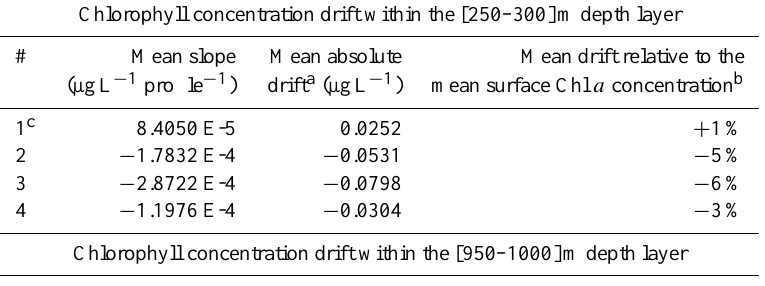
Table 2. Drift assessment of the bio-profilers over their lifetime within the [250–300]m and [950–1000]m depth layers. Chlorophyll concentration drift within the [250–300]m depth